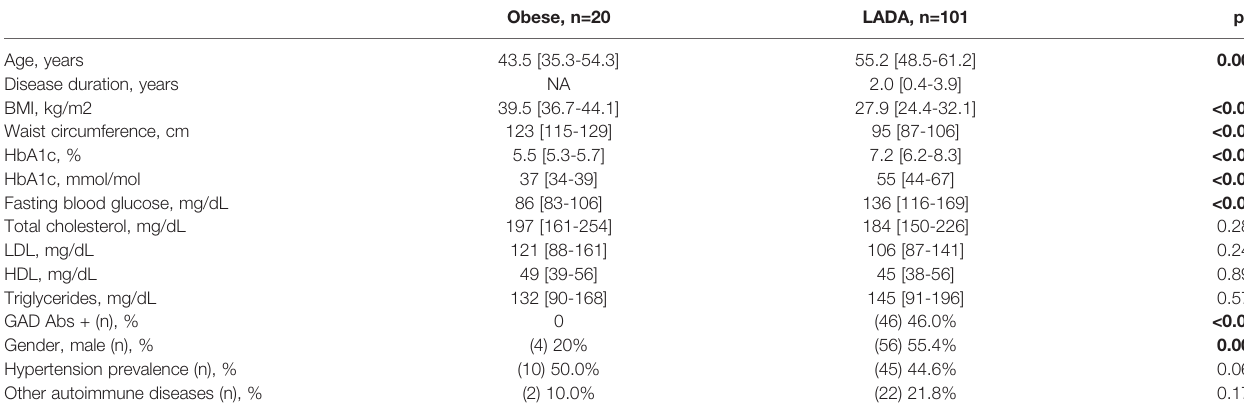
TABLE 1 | Characteristics of LADA and NGT obese subjects enrolled in the study. All subjects reported in the table were positive for IA-2 (256-760) Abs. Obese,